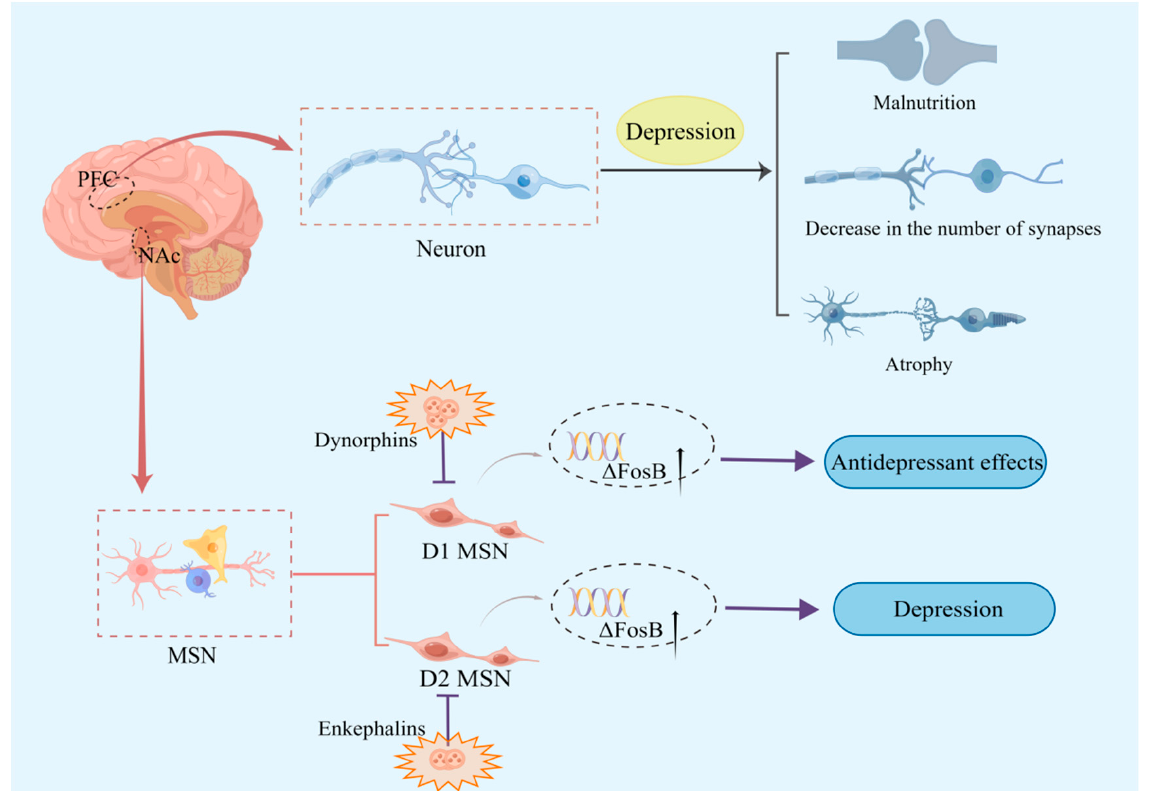
Figure 1. Association of neurons with depression. D1 MSN activity may enhance antidepressant benefits, but D2 MSN activation may exacerbate depressed symptoms. Dynophins block D1-MSN antidepressant effects, while enkephalins block D2-MSN enhancement of activity. Additionally, higher ∆ FosB expression was discovered in the D1 MSN of more adaptable mice and in the D2 MSN of less adaptable animals. Furthermore, animal models of depression showed signs of neuronal malnutrition, atrophy, and a reduced number of